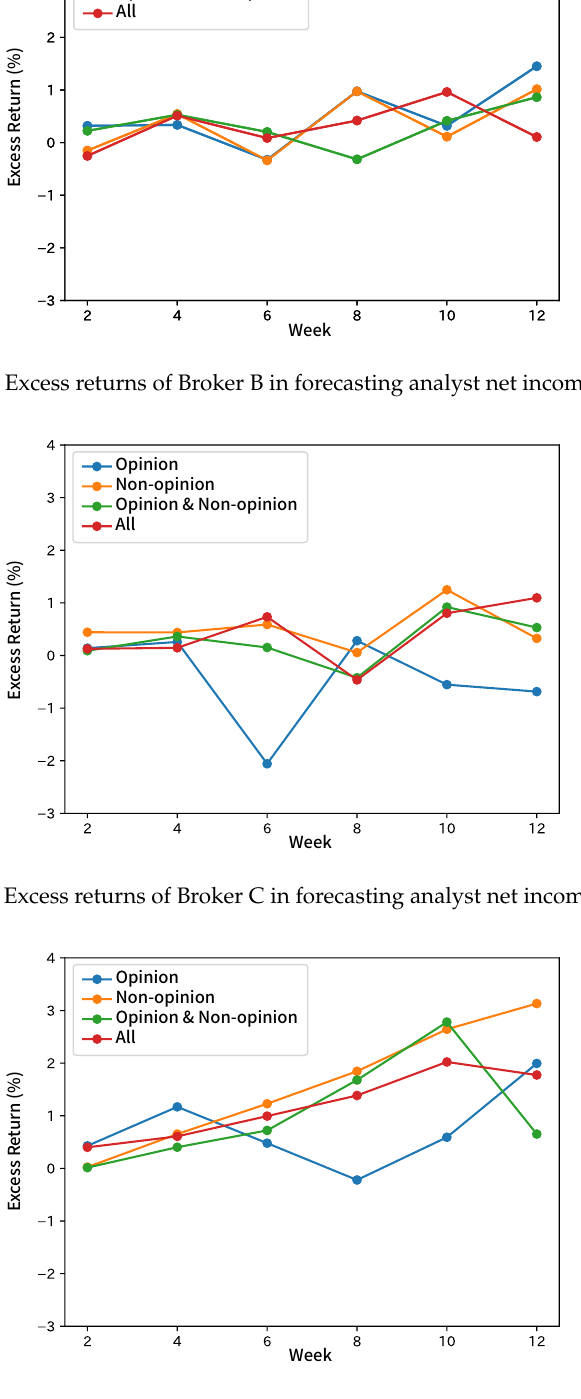
Figure 7. Excess returns of Broker D in forecasting analyst net income